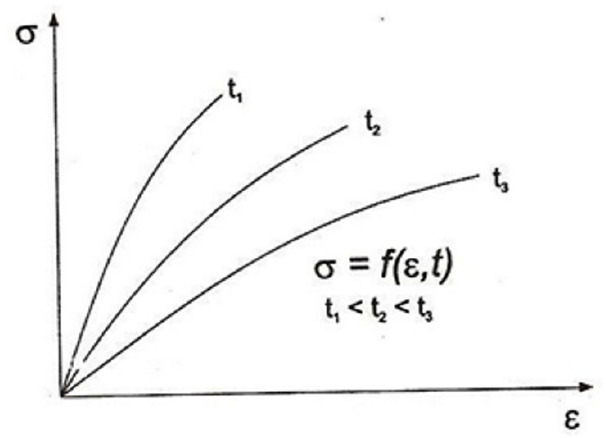
Figure 2. Stress-strain characteristics of the rheological medium [7]. Temperature, humidity, and grain size are also additional factors which may affect the deformation of the tested salt samples. Due to the rheological properties of the salt, even with constant loading of the samples, the deformation increases with time